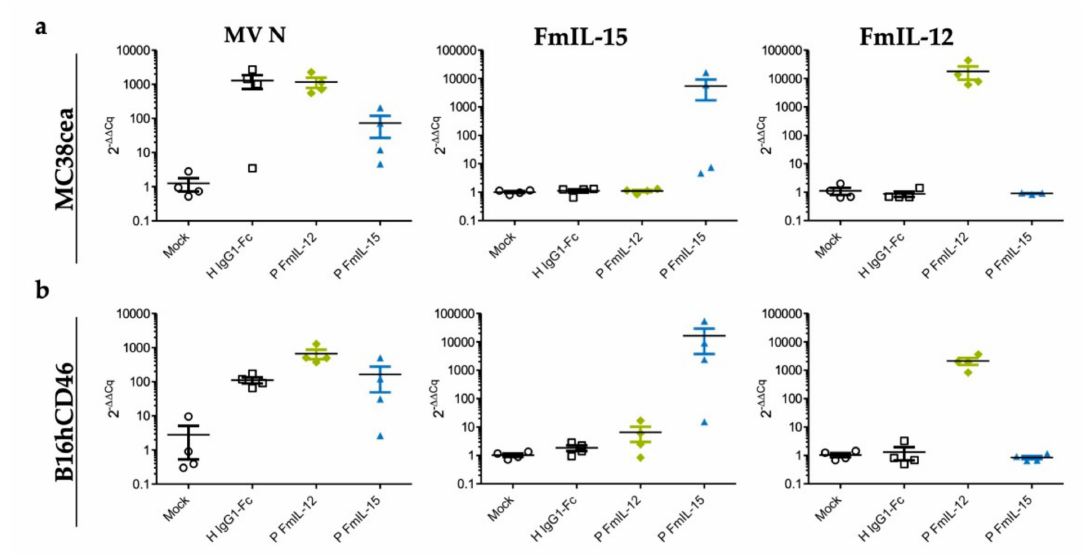
Figure 6. Viral gene expression in vivo. Samples ( n = 4 per group) from MC38cea tumors ( a ) and B16hCD46 tumors ( b ) were collected 24 h after the last treatment and total RNA was extracted. RT-qPCR was performed with primers specific for MV N , FmIL-15 , and FmIL-12 with mL13A as